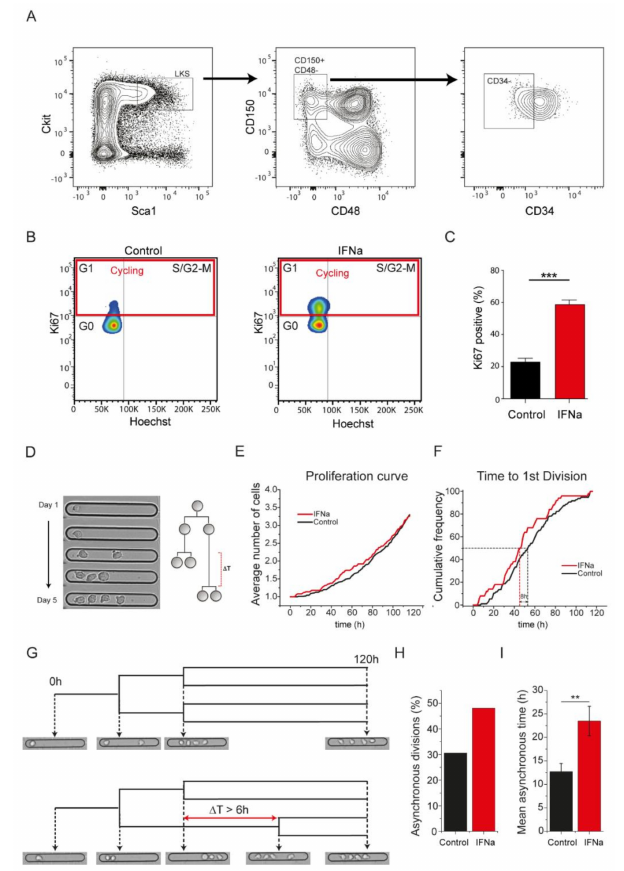
Figure 1. In vivo activation of hematopoietic stem cells (HSCs) by interferon alpha (IFN α ) increases asynchronous cell divisions. ( A ) HSCs were freshly isolated from the bone marrow using Lin- cKit + Sca1 + CD150 + CD48- CD34- markers; ( B ) Cell cycle analysis using Ki67 and Hoechst staining on freshly isolated HSCs from control and IFN α -treated mice. Cells in red box (Ki67 positive) constitute a fraction of HSCs in a cycling state (G1 + S / G2-M phase); ( C ) HSCs isolated from IFN α -treated mice show a significant increase in the cycling fraction (Ki67 positive cells); ( D ) Single-cell proliferation kinetics analysis using live cell imaging of HSCs on a poly(2-hydroxyethyl methacrylate)-trimethylolpropane trimethacrylate copolymer (pHEMA-TMPTA) micro-groove platform; ( E , F ) Proliferation kinetics of live and dividing HSCs isolated from control and IFN α administered mice. The average proliferation over 5 days remains similar in the two conditions, with IFN α -activated cells carrying out the first division much faster (~8 h) as compared with control HSCs; ( G ) Representative example of synchronous division (top) and an asynchronous division (below) with ∆ T > 6 h being used as a threshold for asynchrony; ( H ) IFN α -activated HSCs show a notable increase in the proportion of asynchronous divisions; ( I ) IFN α -activated HSCs show a significant increase of asynchronous time division between daughter cells. *** p < 0.001 and ** p <